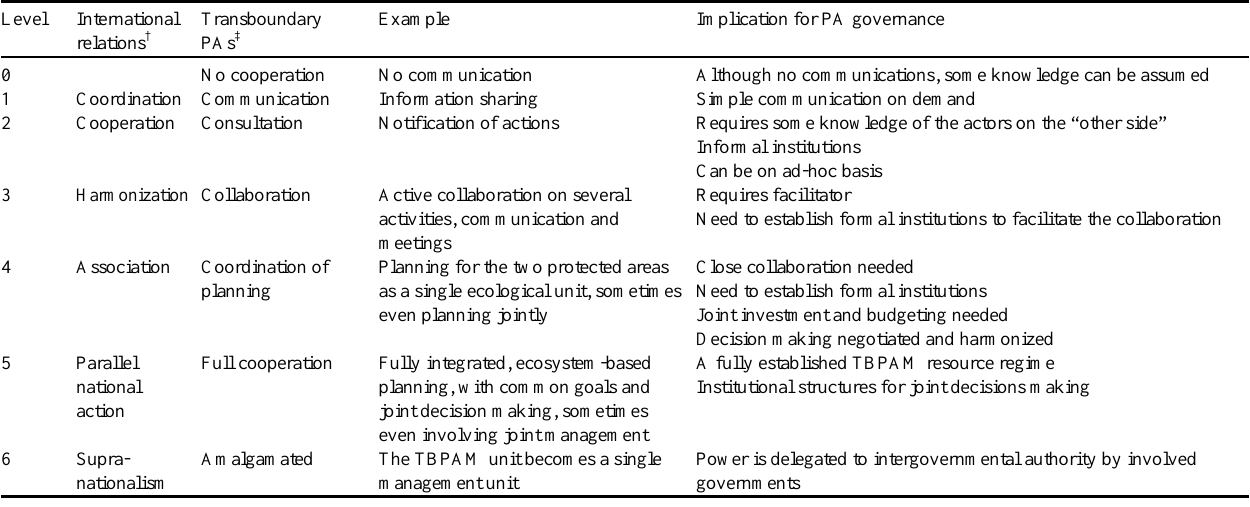
Table 2 . Typology of levels and types of transboundary protected area management (TBPAM) cooperation between adjoining countries. PA = protected areas.